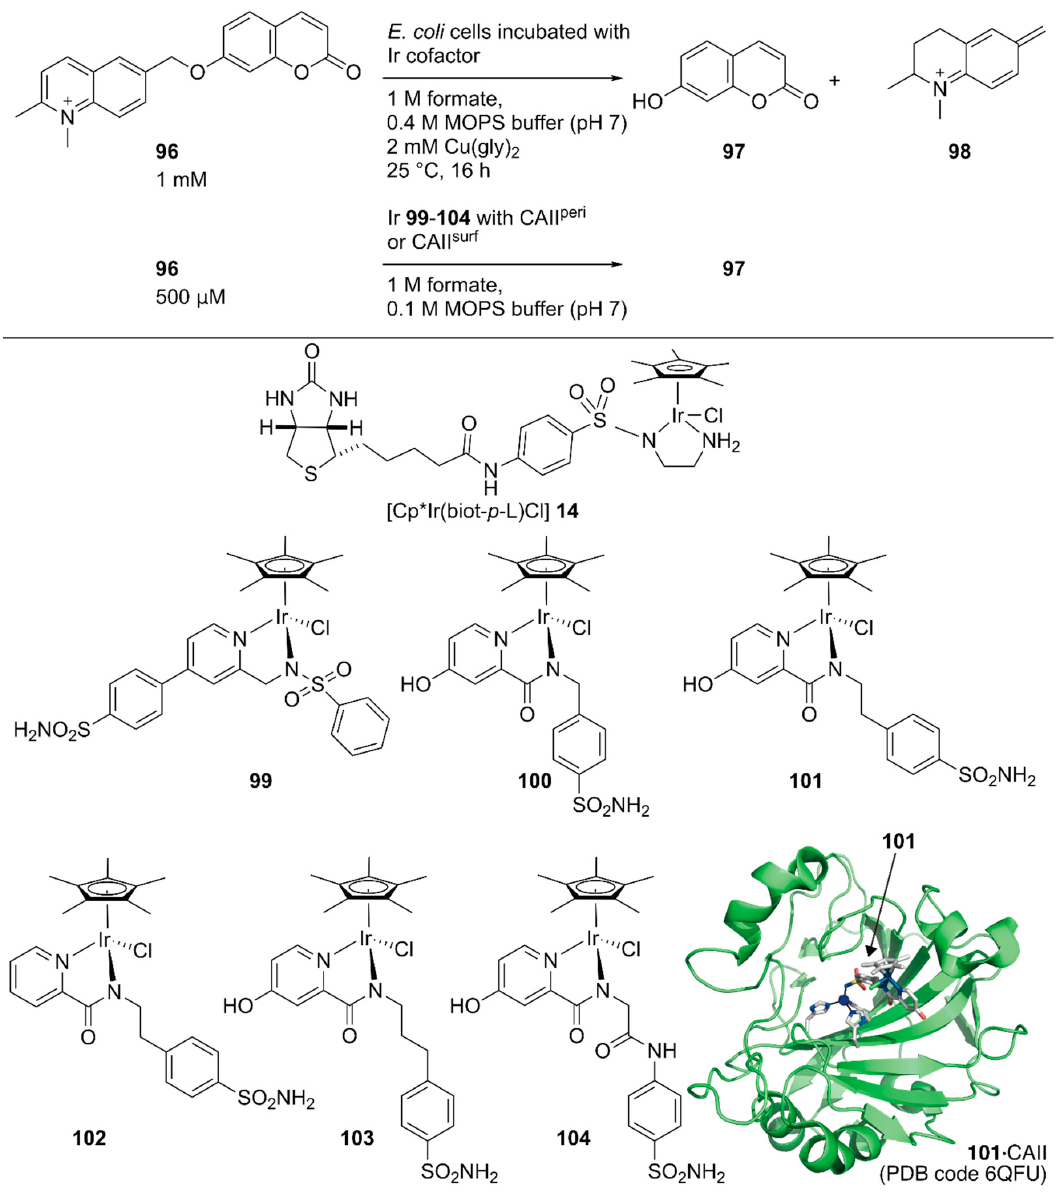
Figure 19. Transfer hydrogenation reaction of a turn-on type fluorescent substrate catalyzed by an ArMs constructed in the periplasm or on the surface of E. coli. for high-throughput screening. Adapted from [117,119].